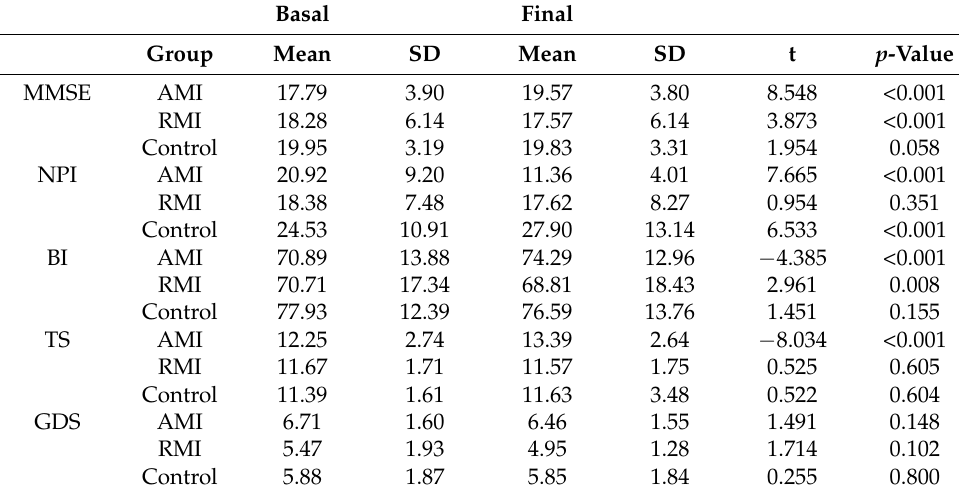
AMI, active music interventions; BI, Barthel Index; GDS, Geriatric Depression Scale; RMI, receptive music intervention; MMSE, Mini Examination of the Mental State; NPI, Neuropsychiatric Inventory SD, standard deviation; TS, Tinetti